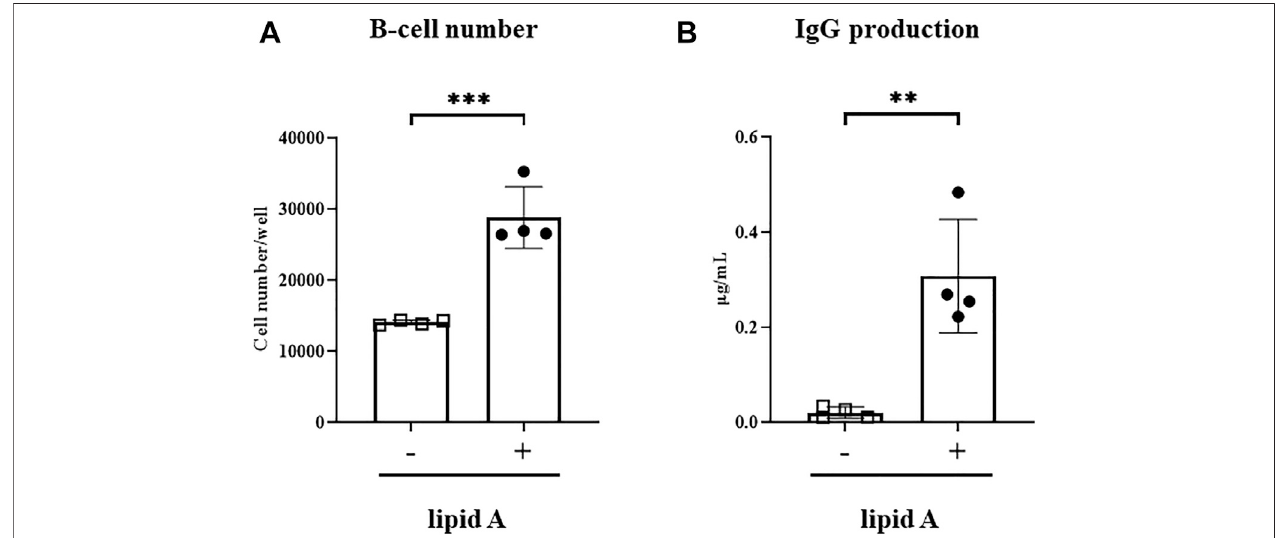
FIGURE5| Alcaligenes lipid Adirectly activates Bcells. Splenic B220 + cells wereisolated fromnaivemice. After4 days ofculture with(+) or without ( – ) Alcaligenes lipid A, (A) live B cells werecounted, and the (B) IgG content in the culture supernatant wasmeasured. Dataare representative oftwoindependent experiments and are presented as mean ± 1 SD, and statistical signi fi cance was evaluated by using Student ’ s t -test ( n (cid:2) 4/group; **, p < 0.01; ***, p < 0.001).